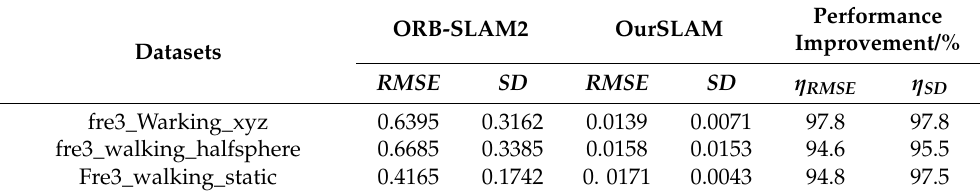
Table 1. Absolute trajectory error comparison results (ATE).